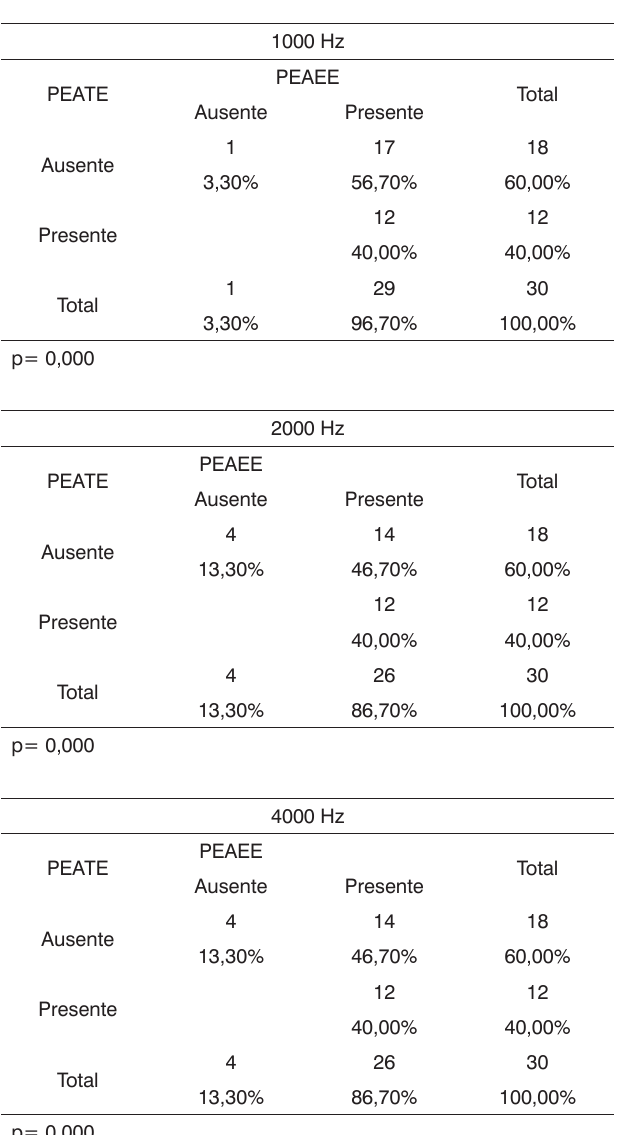
Tabela 2. Distribuições de frequências e porcentagens conjuntas da presença de resposta no PEAEE e PEATE-clique nas frequências de 1000 Hz, 2000 Hz e 4000 Hz.